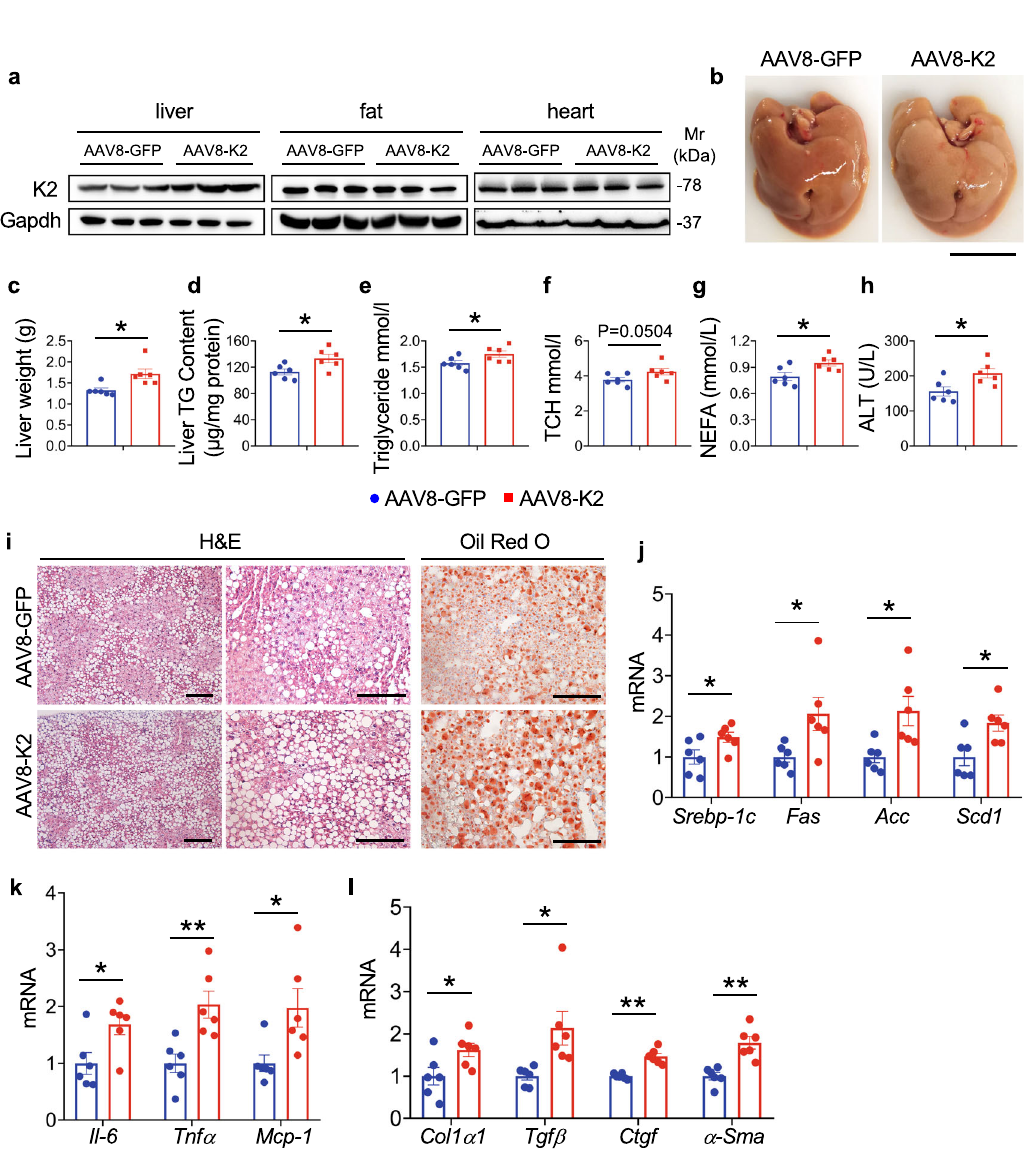
Fig. 3 Overexpression of Kindlin-2 in the liver promotes hepatic steatosis. a Eight-week-old C57BL/6 male mice were injected via tail vein with AAV8 expressing Kindlin-2 (AAV8-K2) or GFP (AAV8-GFP) and fed with HFD for 8 weeks. Livers were harvested and tissue extracts were subjected to western blotting ( n = 3). Protein extracts (20 μ g) were used for western blotting from each sample. b Gross appearance of livers. Scale bar, 1 cm. c Liver weight. d Liver TG levels (normalized to liver weight) ( n = 6). e – h Serum TG, TCH, NEFA, and ALT levels ( n = 6). i Representative H/E staining and Oil Red O staining of liver sections. Scale bar, 100 μ m. j – l qRT-PCR analyses. mRNA expression levels of the indicated genes in liver samples from AAV8-GFP and AAV8-K2 treated groups were determined ( n = 6). c – e , g , h , j – l Data are presented as mean ± SEM. * P < 0.05, ** P < 0.01, determined by two-tailed Student ’ s t -test. i Data are representative of three biologically independent